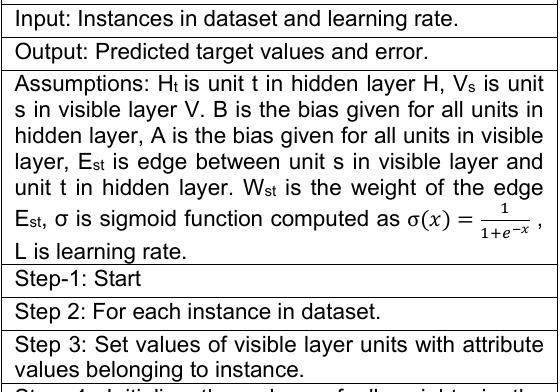
Algorithm: Deep belief network